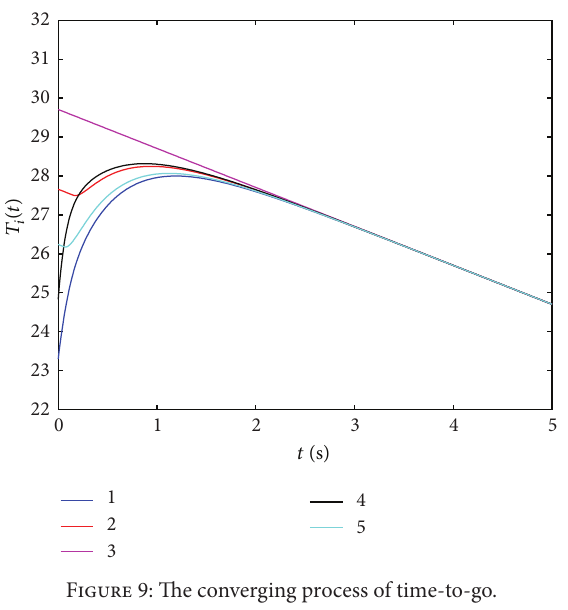
Figure 9: The converging process of